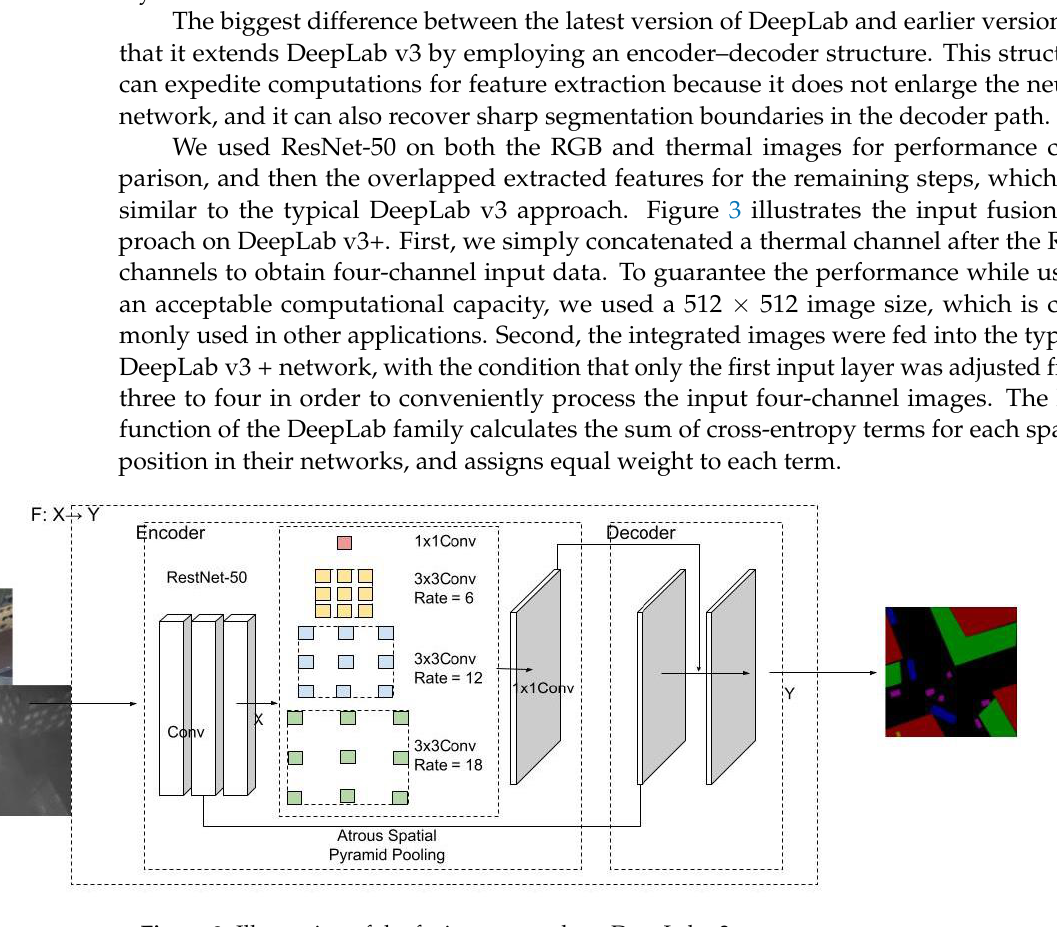
Figure 3. Illustration of the fusion approach on DeepLab v3+.